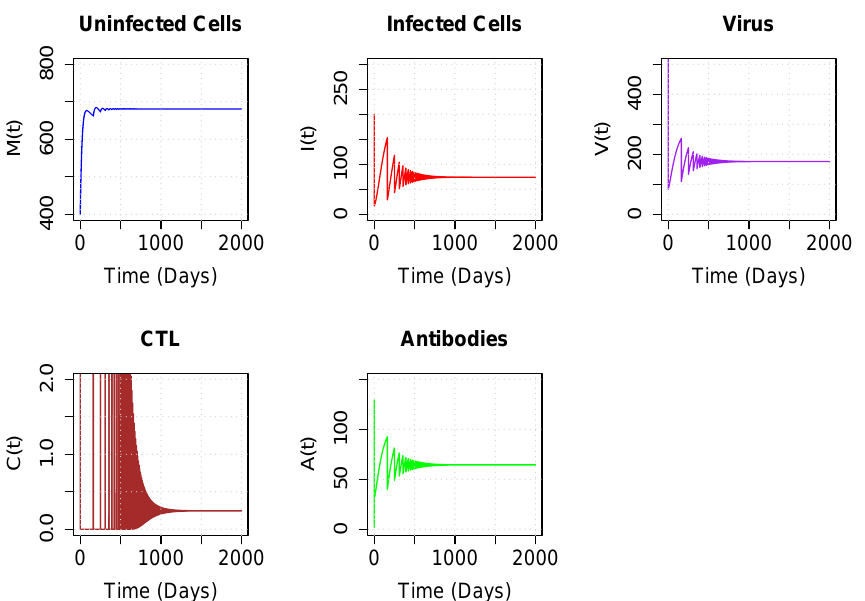
Figure 4. Trajectory plots of populations for parameters corresponding to the coexistence region, above the asymptote. Parameter values are set to sample values of Table 1, with ψ = 0.7 and α = 20. Initial conditions are M 0 = 400, I 0 = 200, V 0 = 10,000, C 0 = 10 and A 0 =